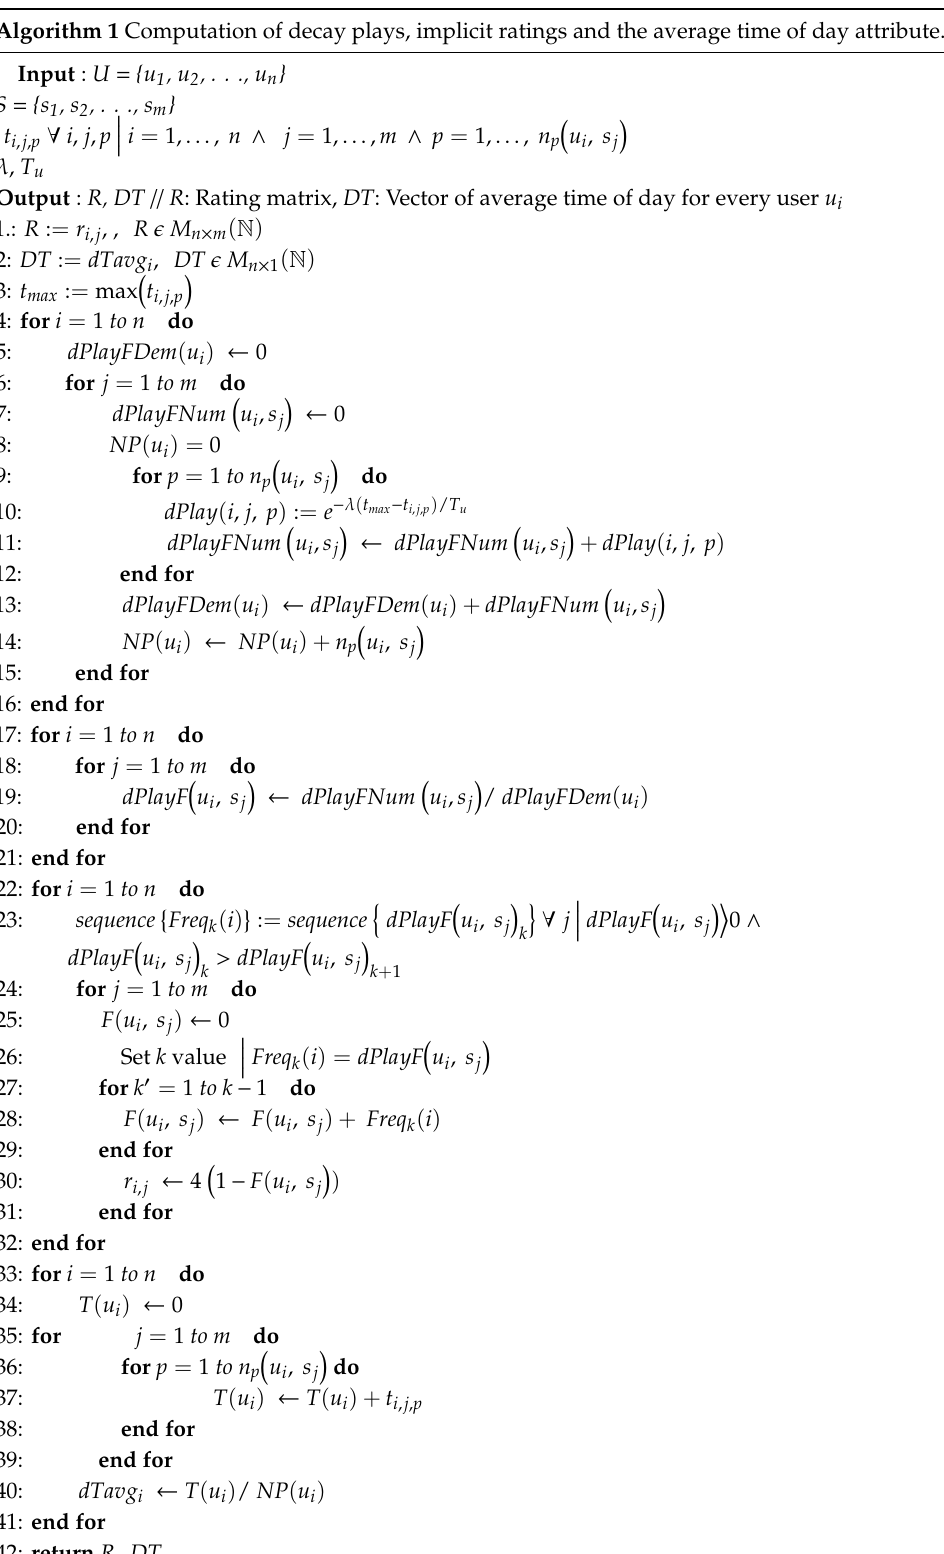
Algorithm 1 Computation of decay plays, implicit ratings and the average time of day